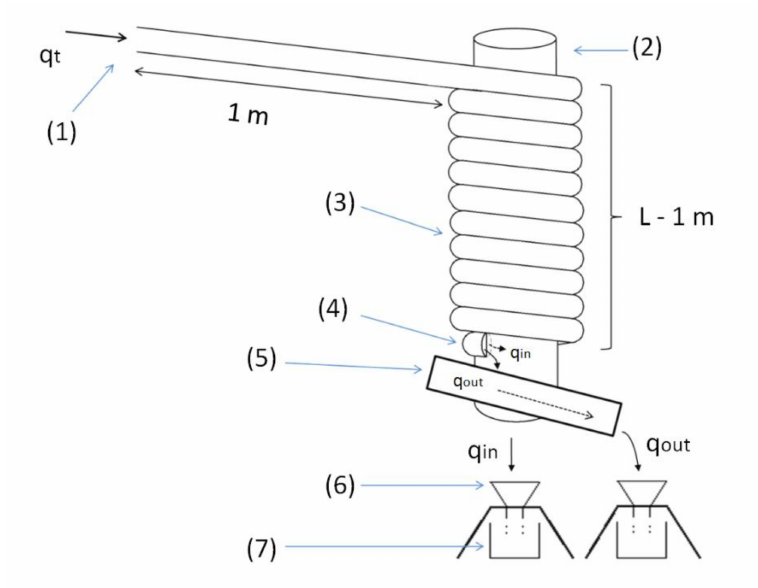
Figure 3. Helical separator scheme: (1) dispersion (emulsion) input; (2) coil mold; (3) helical pipe coil; (4) split zone; (5) gutter; (6) funnel; (7)